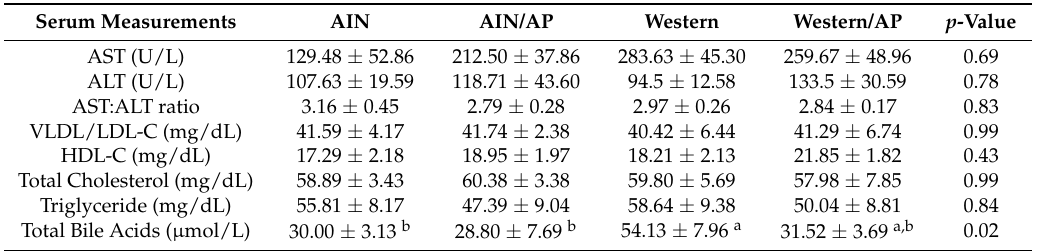
Table 7. Effect of consumption of different diets substituted with apple pomace (10% g/kg) by growing female rats on serum measurements of liver function enzymes, cholesterol, and bile acids following 8 weeks of